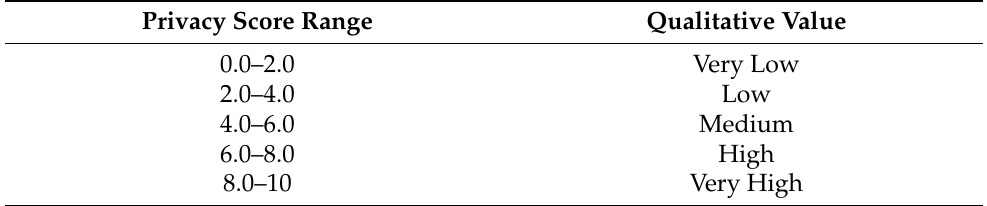
Table 5. Five-tier scale values for privacy